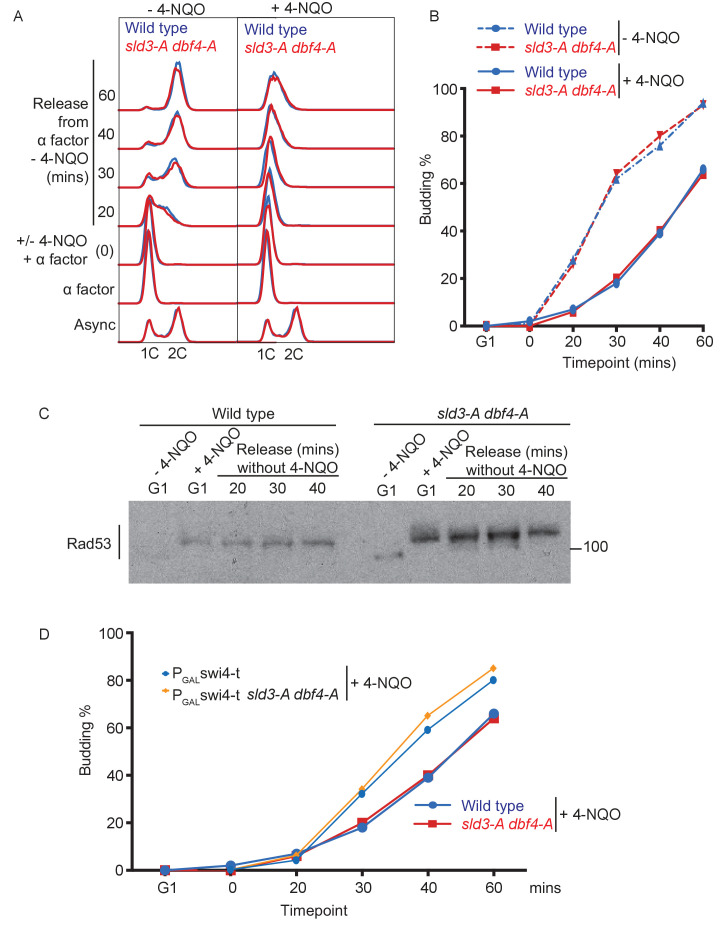
4-NQO addition in G1 phase delays the G1/S transition.(A) Flow cytometry of the indicated strains, which were grown overnight in YPraffinose and arrested in G1 phase with alpha factor (G1 time point). Strains were then held in G1 phase for an extra 30 min by the addition of fresh alpha factor plus galactose, with or without 0.5 μg/ml 4-NQO. Cells were washed into fresh YPgalactose medium to release into S-phase. Note that YPraffinose and galactose medium was used in this experiment to match the exact conditions that were used in the main Figure 4B with the PGAL-swi4-t strains, allowing a direct comparison, as in (D). (B) Budding index (a G1 cyclin/CDK-mediated event) from experiment in (A). (C) Rad53 western blot from the 4-NQO-treated samples in (A). (D) Overlay of budding profiles (from Figure 4C and this Figure B) between strains expressing or not expressing Swi4-t. Swi4-t, which cannot be inhibited by Rad53, causes earlier activation of G1 cyclin/CDK as shown here by budding.